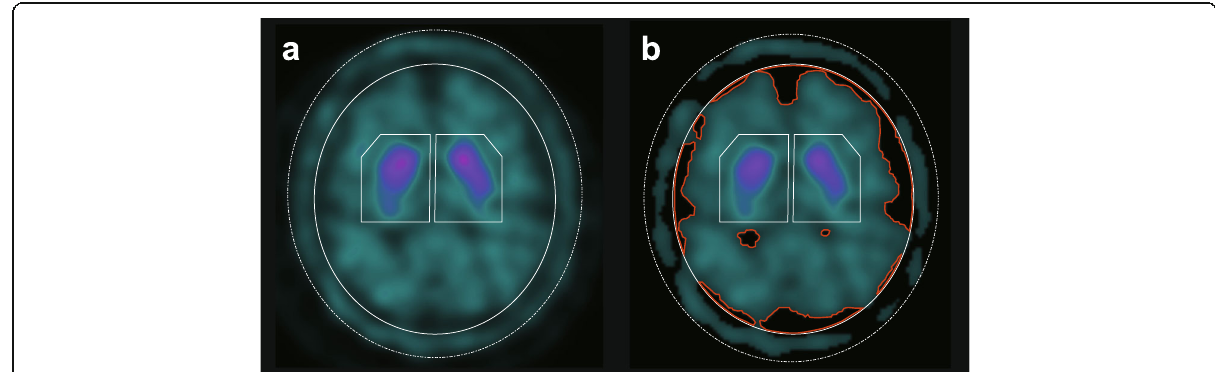
Fig. 2 VOI settings with and without the CSF-mask algorithm in a DLB case. a The VOI setting without the CSF-mask algorithm and b the VOI setting with the CSF-mask algorithm, where CSF-low-count areas are eliminated (regions encompassed by the red line). SBR indices calculated without the CSF-mask algorithm were 4.77 (R) and 4.72 (L) ( a ), while those calculated with the CSF-mask were 3.51 (R) and 3.50 (L) ( b ). The subtle diffuse reduction of tracer uptake in the bilateral striatum is correctly evaluated using the CSF-mask algorithm. VOI volume of interest, CSF